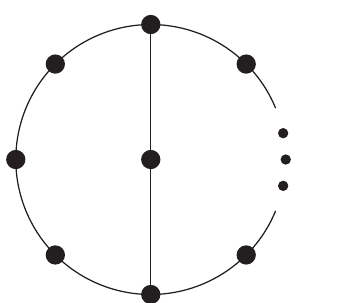
Figure 9: A graph for the degree sequence d ∗ and L � 2.